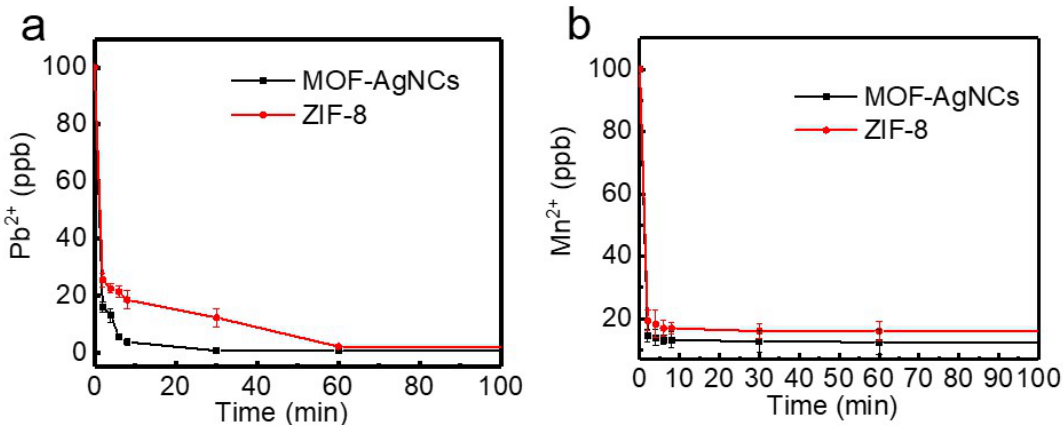
Figure 7. The removal of Pb 2 + ( a ) and Mn 2 + ( b ) in the presence of MOF-AgNCs and ZIF-8 as a function of time.